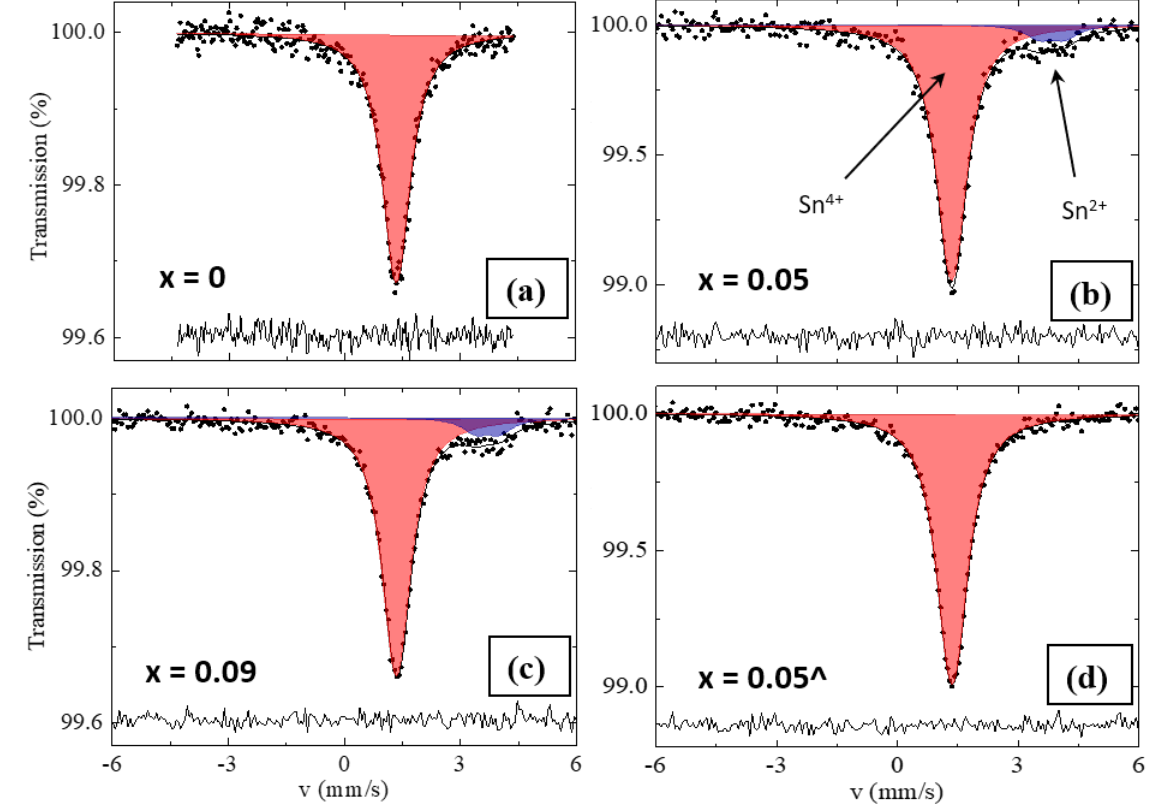
Figure 3. ( a – c ) Mössbauer spectra of the product of reduction of Cs 2 SnI 6 with gallium melt with x = 0–0.09; ( d ) SS sample with x = 0.05^. x = 0–0.09; ( d ) SS sample with x =